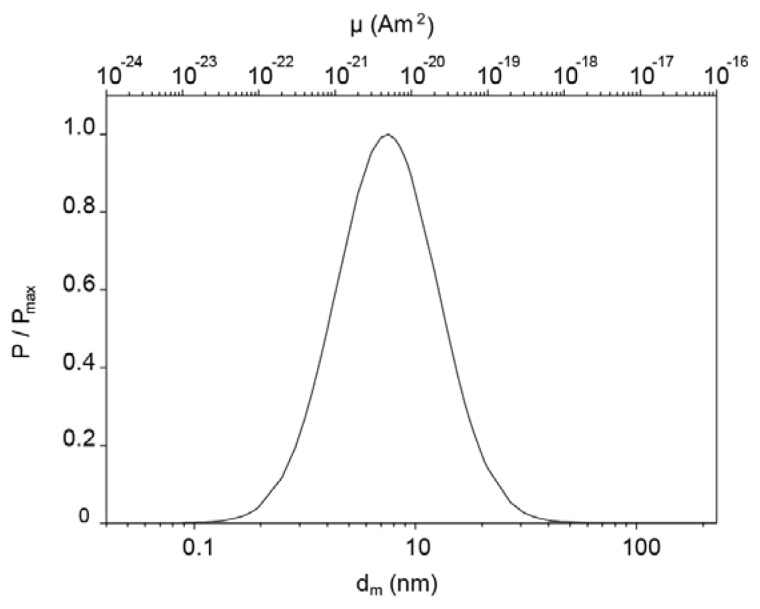
Distribution curves of the magnetic moment and the effective magnetic diameter of the cobalt ferrite nanoparticles, assuming lognormal distributions, calculated using Equations 6 and 7. P is scaled to the maximum of the distribution, Pmax.